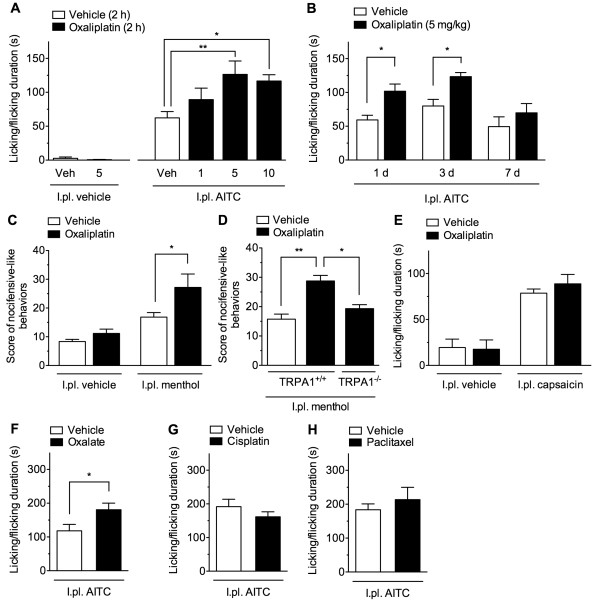
A single administration of oxaliplatin, but not cisplatin and paclitaxel, enhances AITC-evoked nocifensive behaviors. ( A) Two hours after a single administration of vehicle or oxaliplatin (1, 5 or 10 mg/kg), mice received an intraplantar injection of vehicle ( n = 3) or AITC (0.1%, 20 μl; n = 7–14). ( B) 1, 3 or 7 days after a single administration of vehicle or oxaliplatin (5 mg/kg), mice received an intraplantar injection of AITC (0.1%, 20 μl). n = 5–6. ( C) Two hours after a single administration of vehicle or oxaliplatin (5 mg/kg), mice received an intraplantar injection of vehicle or menthol (1.6 μg, 20 μl). n = 6. ( D) TRPA1+/+ or TRPA1−/− mice were intraperitoneally administered vehicle or oxaliplatin (5 mg/kg) 2 h before the menthol-evoked nocifensive behaviors. n = 3–4. ( E) Two hours after a single administration of vehicle or oxaliplatin (5 mg/kg), mice received an intraplantar injection of vehicle or capsaicin (160 μg, 20 μl). n = 6. ( F– G) Two hours after a single administration of oxalate (1.7 mg/kg; F), cisplatin (5 mg/kg; G), paclitaxel (6 mg/kg; H) or vehicle, mice received an intraplantar injection of AITC (0.1%, 20 μl). n = 6–7. AITC- and capsaicin-evoked nocifensive behaviors were measured for 20 min and 5 min, respectively; menthol-evoked nocifensive-like behaviors were scored for 5 min. Data are presented as the means ± S.E.M. * p < 0.05; ** p < 0.01; *** p < 0.001.